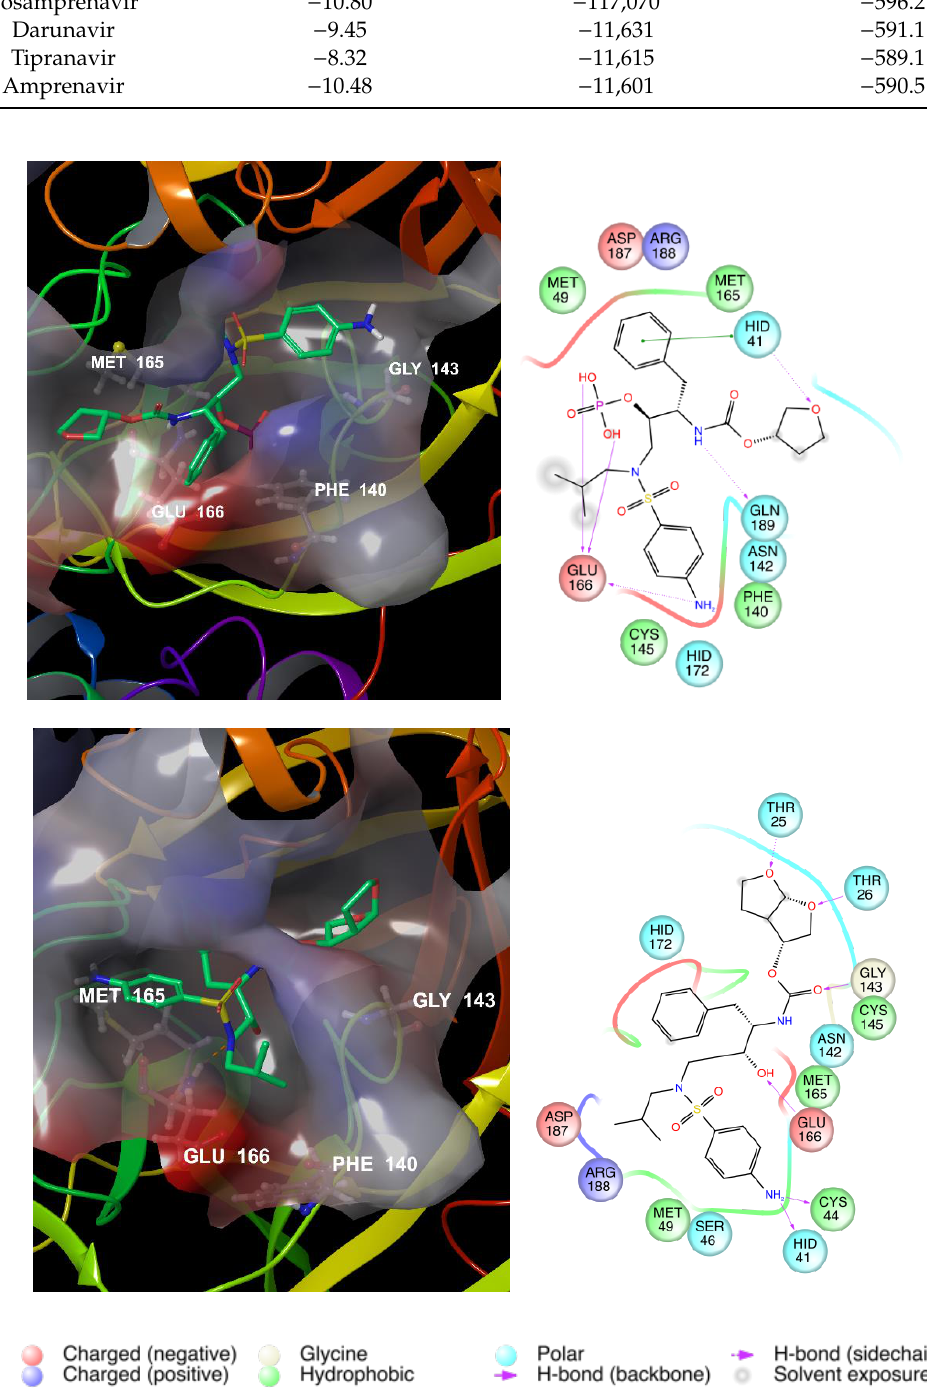
Figure 5. Fosamprenavir (top) and darunavir (bottom) binding to the COVID-19 M pro active site.